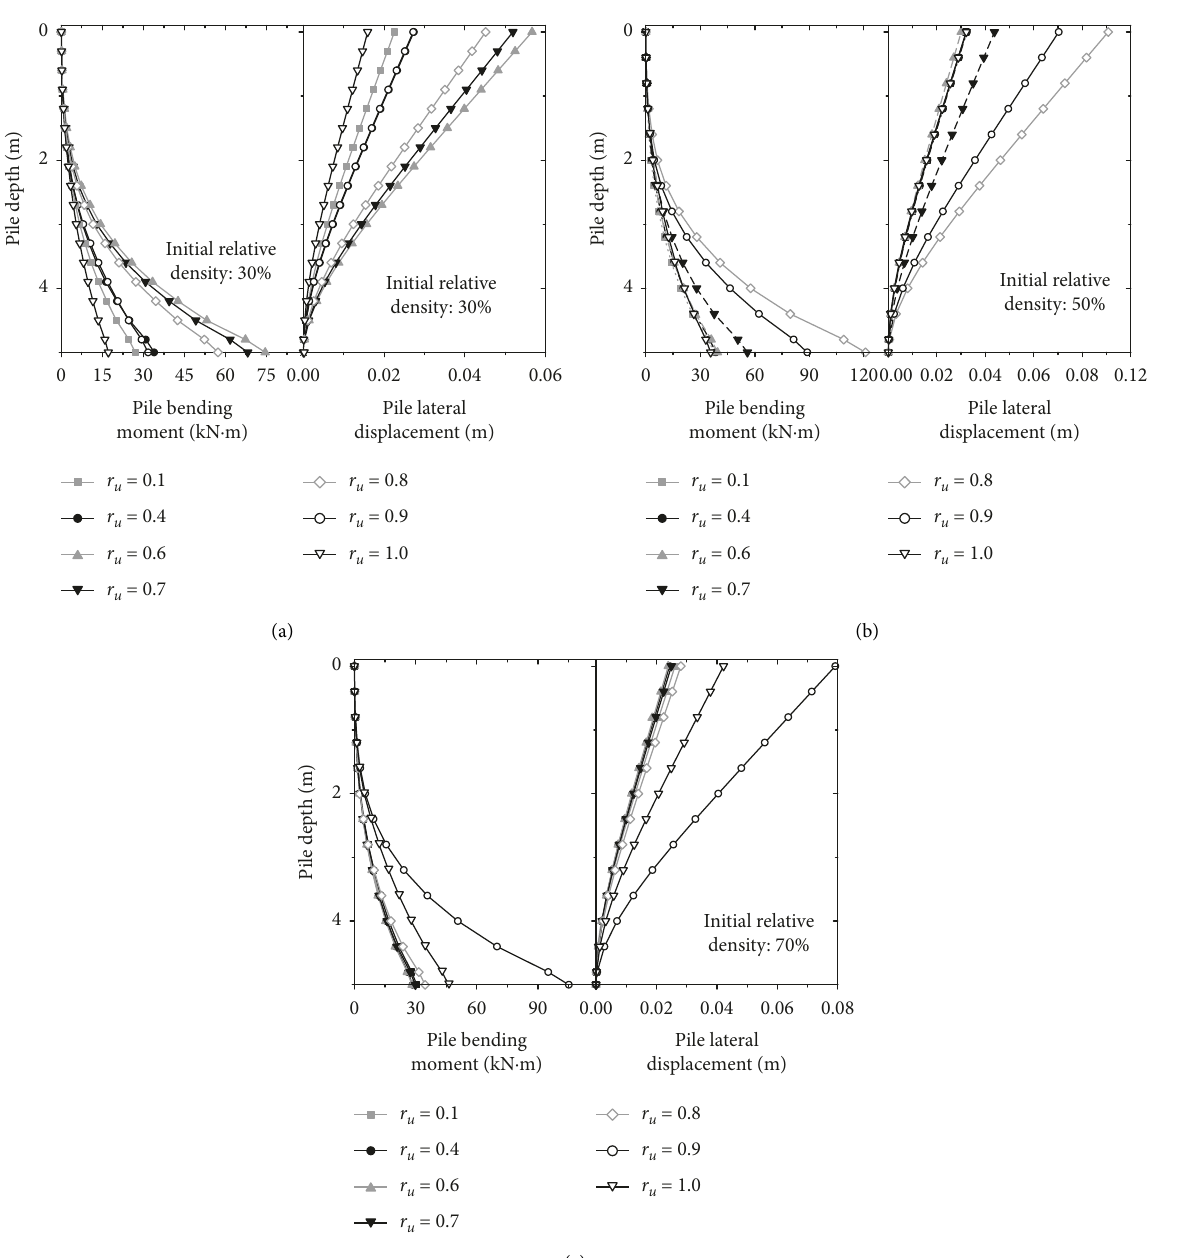
Figure 7: Effect of relative density on pile-soil interaction considering rate-dependent: (a) relative density of 30%; (b) relative density of 50%; (c) relative density of